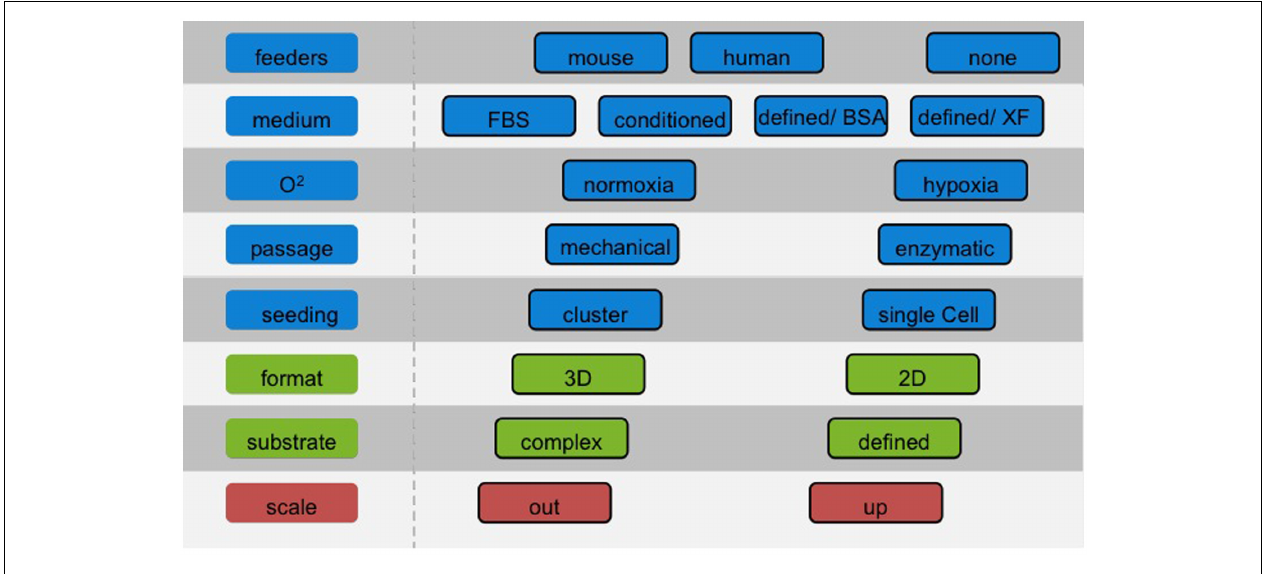
FIGURE 1 | Choosing the right cell culture conditions for hPS cells. The number of cells required for a screening campaign is typically less substantial than for cell therapies. Nonetheless, it is of paramount importance to choose the appropriate cell culture conditions